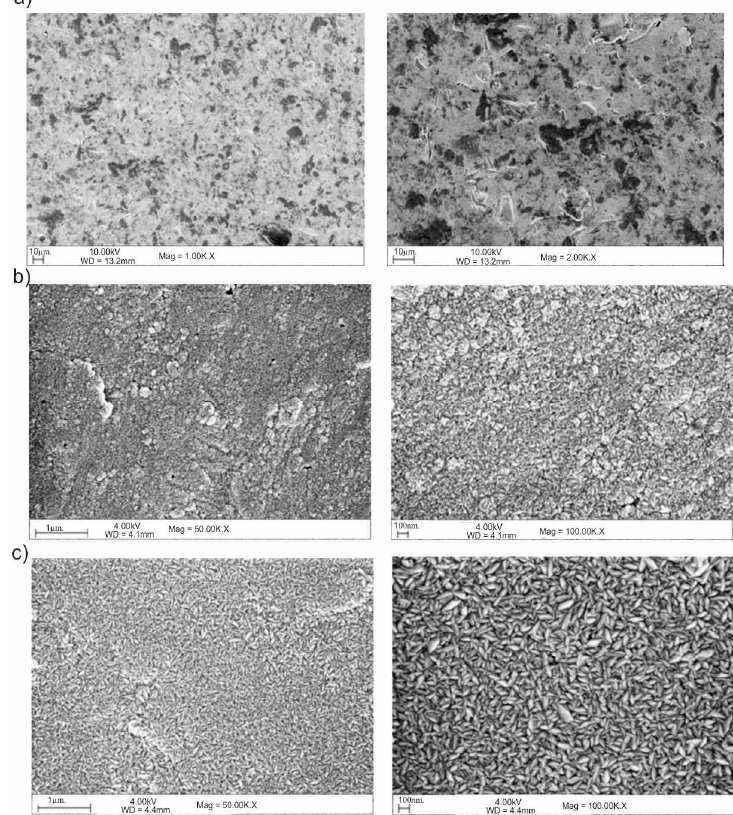
Figure 16. Example of the surface morphology in ZnO-coated samples: ( a ) initial state; ( b ) 500_100°C, ( c ) 1500_100°C.